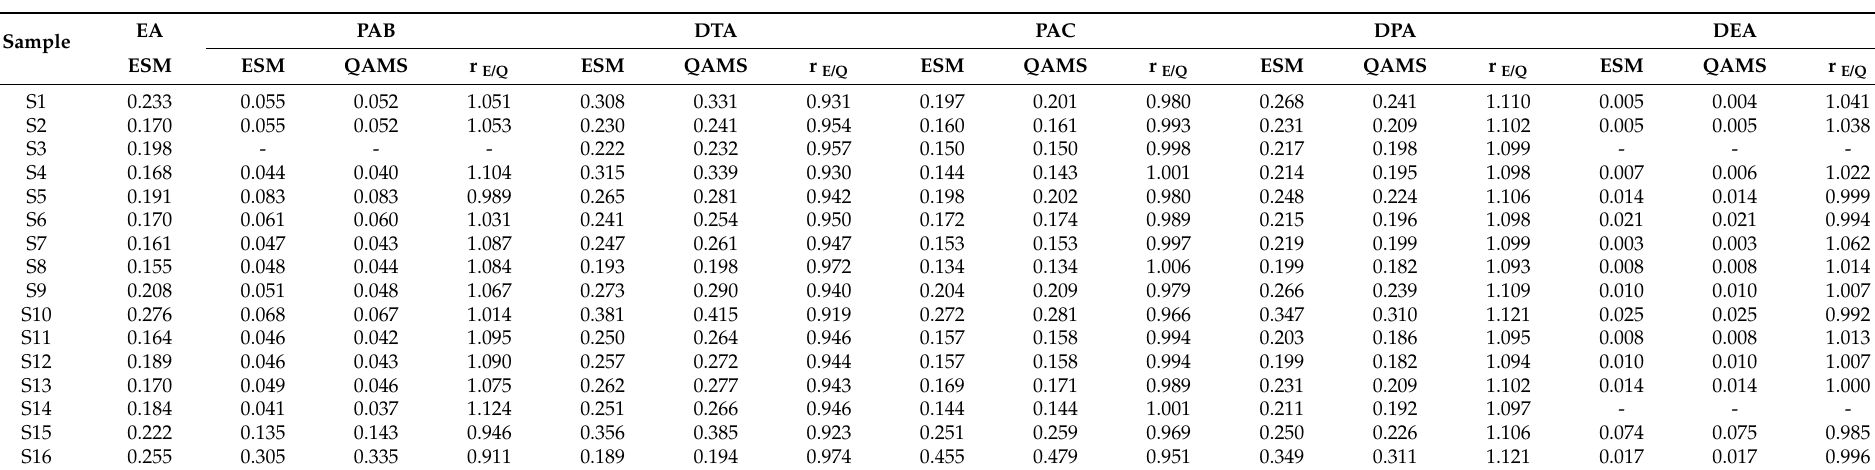
Table 3. Concentrations of six components in 16 batches of PC as determined by the ESM and QAMS method